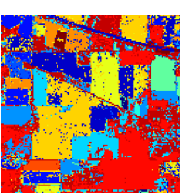
Figure 3. Classification results of